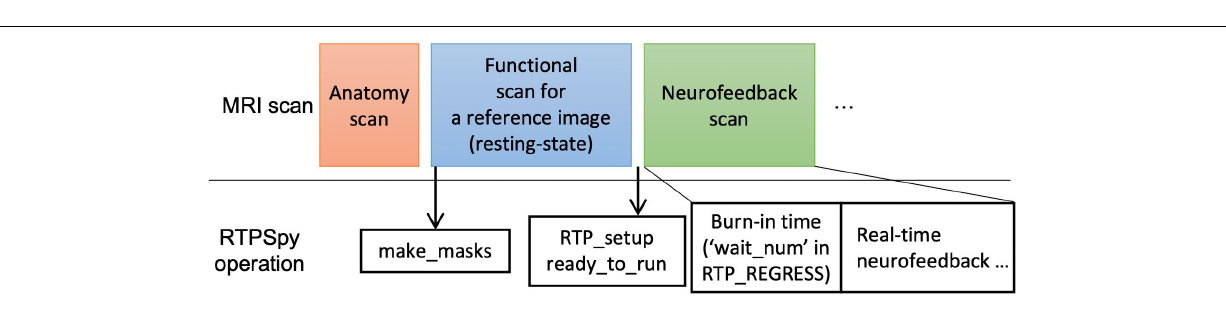
FIGURE 7 | Example of real-time fMRI session procedure with RTPSpy. This is an example session and not a requirement for library